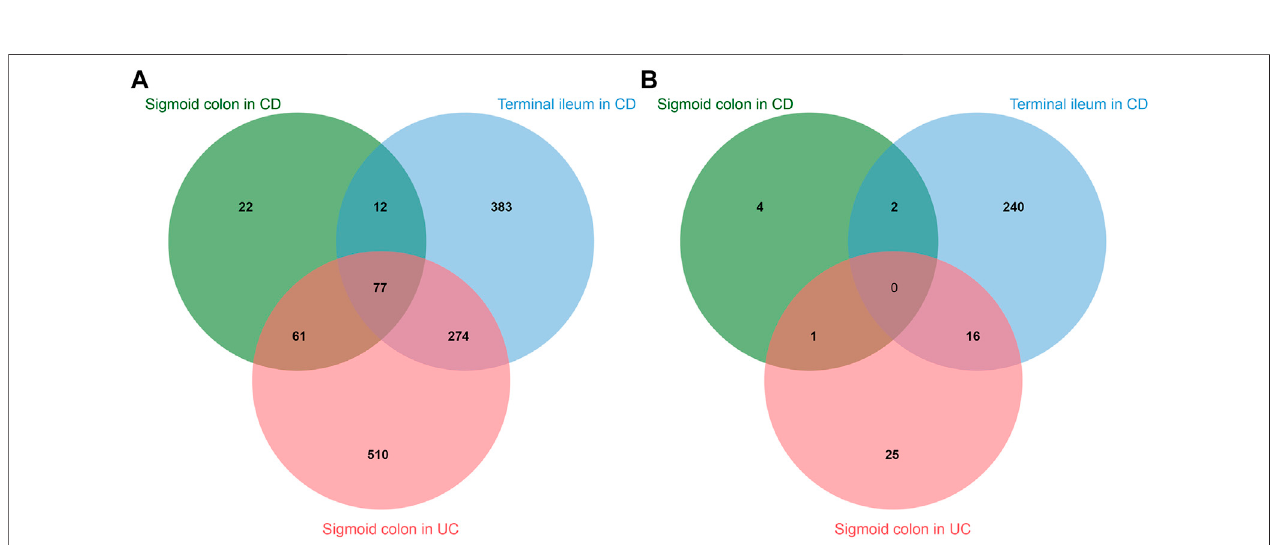
FIGURE 5 | Intersections of differentially expressed genes in sigmoid colon of patients with Chron ’ s disease (CD), terminal ileum of patients with CD, and sigmoid colon of patients with ulcerative colitis (UC). (A) — upregulated genes. (B) — downregulated genes.